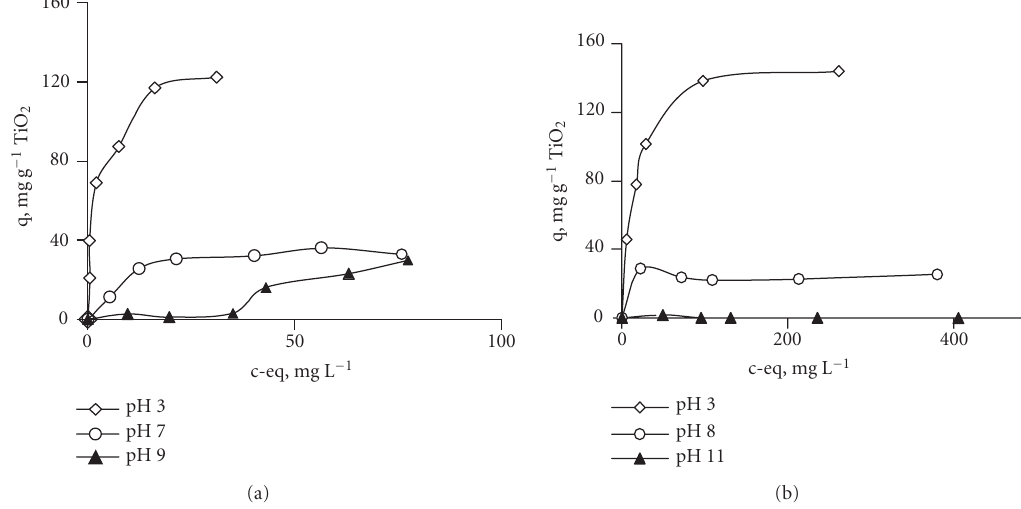
Figure 3: E ff ect of pH on the adsorption isotherms at 25 ◦ C for (a) humic acids and (b) lignin on the TiO 2 surface: c-eq is the equilibrium concentration of pollutant in the solution and q is the amount of pollutant adsorbed by TiO 2 .